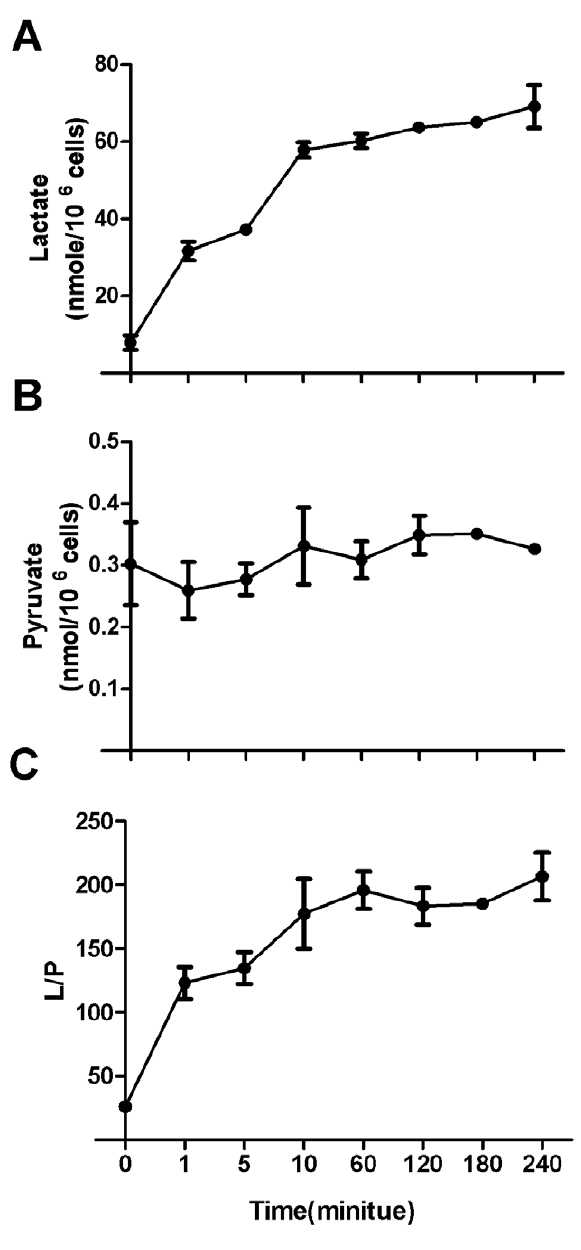
Figure 2. The effect of extracellular lactate concentration on intracellular lactate concentration and intracellular L/P ratio in Bcap-37 cells. Bcap-37 cells were incubated in complete RPMI-1640 medium containing 12 mM glucose supplemented with 20 mM lactate. At the indicated time point, intracellular lactate and pyruvate were measured. (A) Intracellular lactate; (B) Intracellular pyruvate; (C) Intracellular L/P ratio. Data are mean 6 SD. Data were confirmed by 2 independent